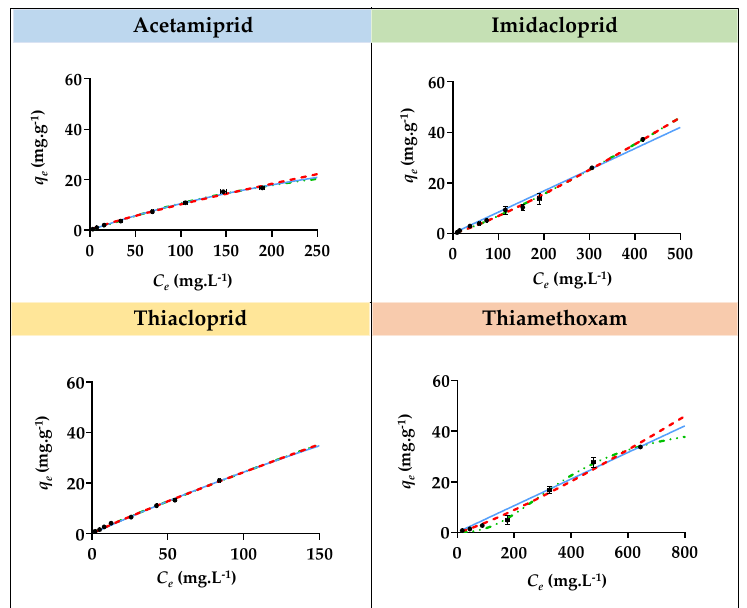
Figure 5. Adsorption isotherms curves for imidacloprid, acetamiprid, thiacloprid, and thiamethoxam insecticides with [Si][N 3444 ]Cl. The black dots correspond to experimental data, the continuous blue line corresponds to the fitting of the experimental data with the Langmuir model, the red dashed line corresponds to the fitting with the Freundlich model, and the green dashed and pointed line corresponds to the fitting with the SIPS model.